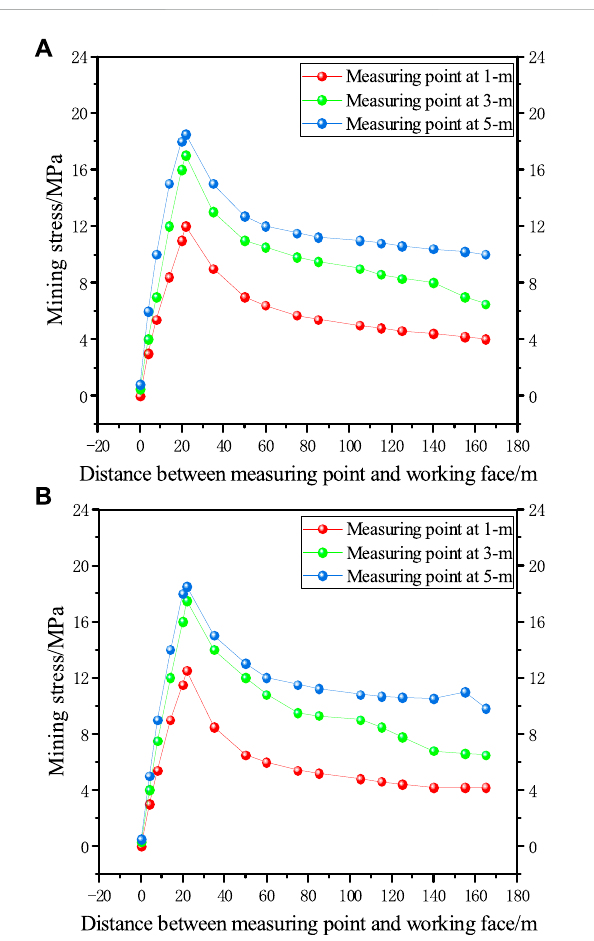
FIGURE 19 Vertical mining stress curves of each measuring point in the track roadway of the second measuring station. (A) Upper side of the track roadway. (B) Lower side of the track